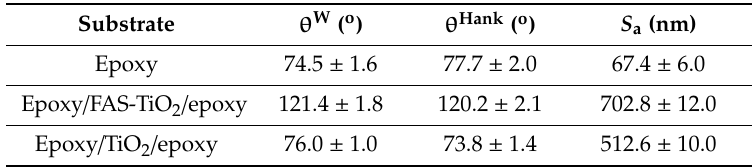
Table 1. Contact angles ( θ W and θ Hank ) and average surface roughness ( S a ) of epoxy, epoxy / FAS-TiO 2 / epoxy and epoxy / TiO 2 / epoxy